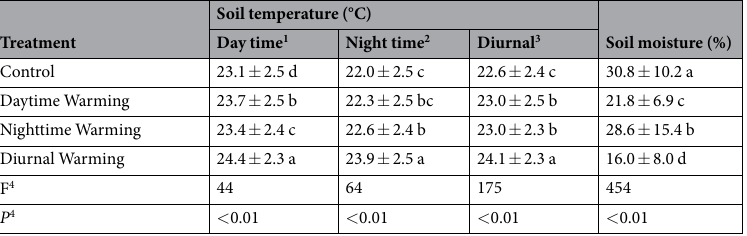
Table 1. Statistic results of asymmetric warming on soil temperature (Mean ± SD) and soil moisture (Mean ± SD). 1 Day time means 06:00–18:00. 2 Night time means 18:00–06:00. 3 Diurnal means 06:00–06:00. 4 Repeated measures ANOVA. Values in each column followed by different letter (a–d) are significant difference based on